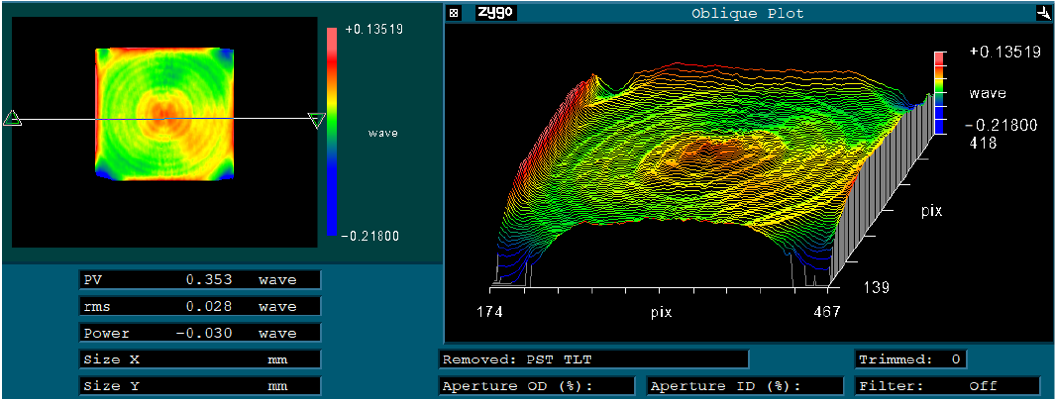
Figure 15. Shape accuracy of the SPDT surface after laser modification.